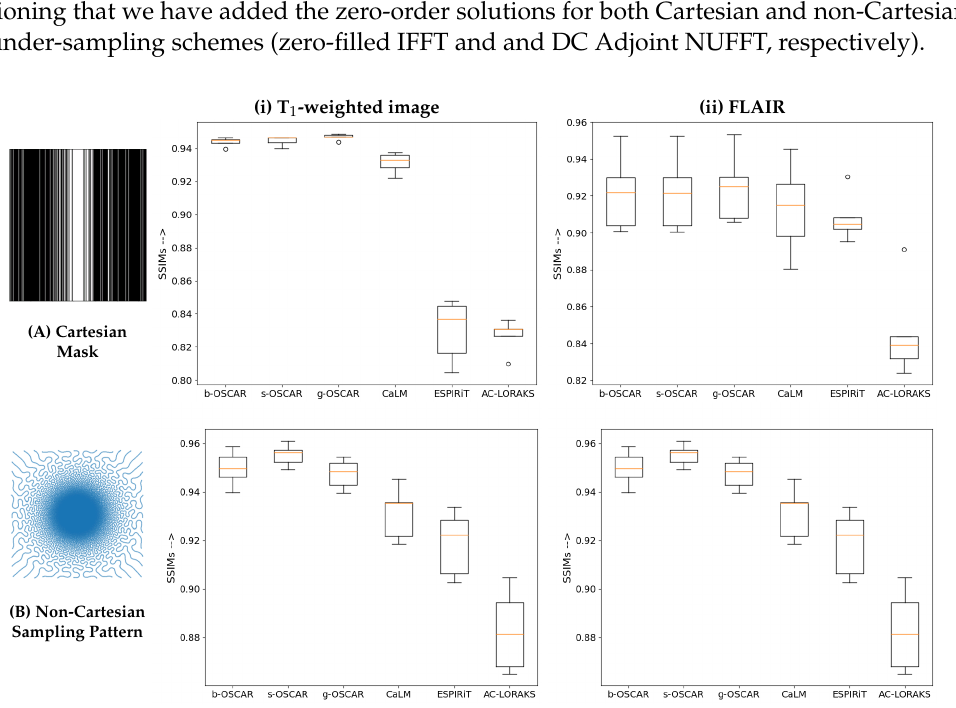
Figure 2. Phase processing for better visualization of the brain structure and hence easier comparisons. (a) Raw wrapped phase image. (b) Unwrapped phase image. (c) High pass filtered phase image, notice that the structures in the brain are more visible here. (d) Contrast stretching of 2nd and 98th percentiles of intensity values that permits contrast enhancement and improved visualization.